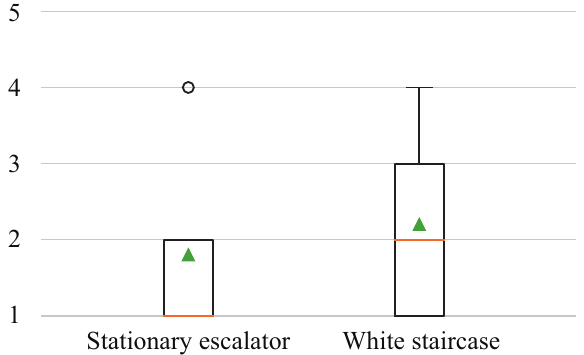
Figure 14. Results of the questionnaire “Compared to the stairs without the AR display, the stairs are more difficult to